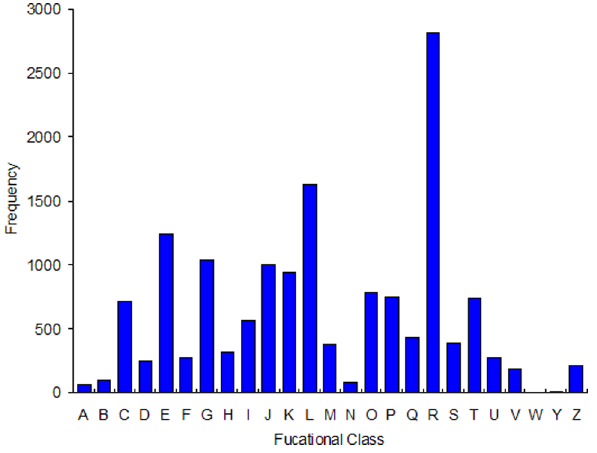
Figure 2. COG categories of the unigenes. Note: Class definition, Number of this class, Percent of this class (%). A: RNA processing and